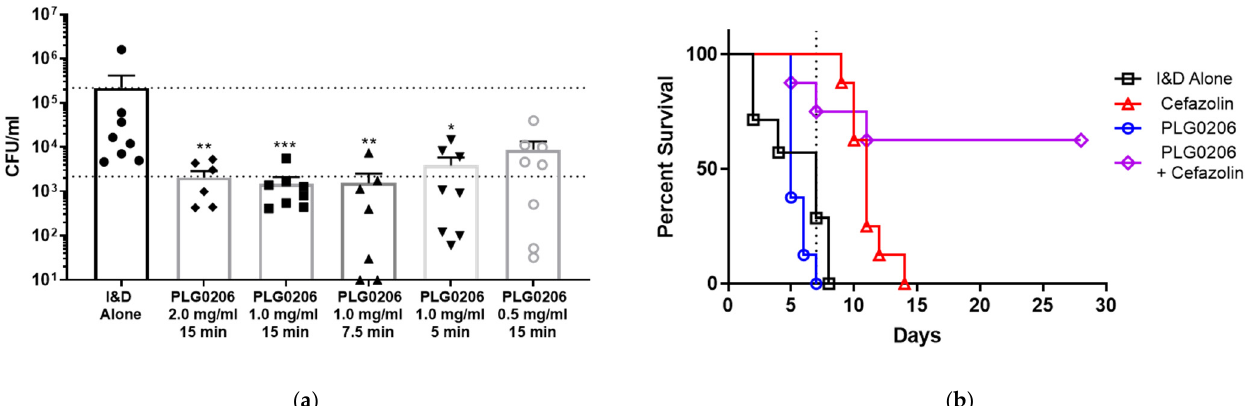
Figure 3. Activity of PLG0206 for treating S. aureus PJI in a large animal model. ( a ) In vivo intra- articular treatment of PJI with PLG0206 for 15 min reduced S. aureus biofilms. * p < 0.05, ** p < 0.01, *** p < 0.001. ( b ) Treatment with cefazolin systemically and PLG0206 intraoperatively resulted in increased survival. Data from Brothers et al., 2021 [38] .